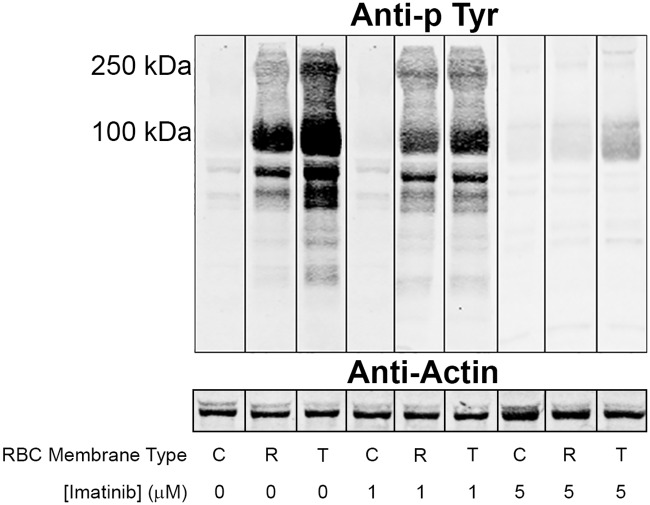
Effect of imatinib on tyrosine phosphorylation of band 3 in P. falciparum infected erythrocytes.Membranes were isolated from uninfected control erythrocytes (C) or P. falciparum-infected erythrocytes treated at the ring (R) or trophozoite (T) stage with the indicated concentrations of imatinib. Isolated membranes were separated by SDS-PAGE and transferred to nitrocellulose prior to western blotting with an anti-phosphotyrosine antibody. The tyrosine phosphorylated band at 100kDa is band 3, as demonstrated by mass spectrometry analysis of phosphopeptides [12]. Anti-actin staining of the same blots is presented as gel loading control.